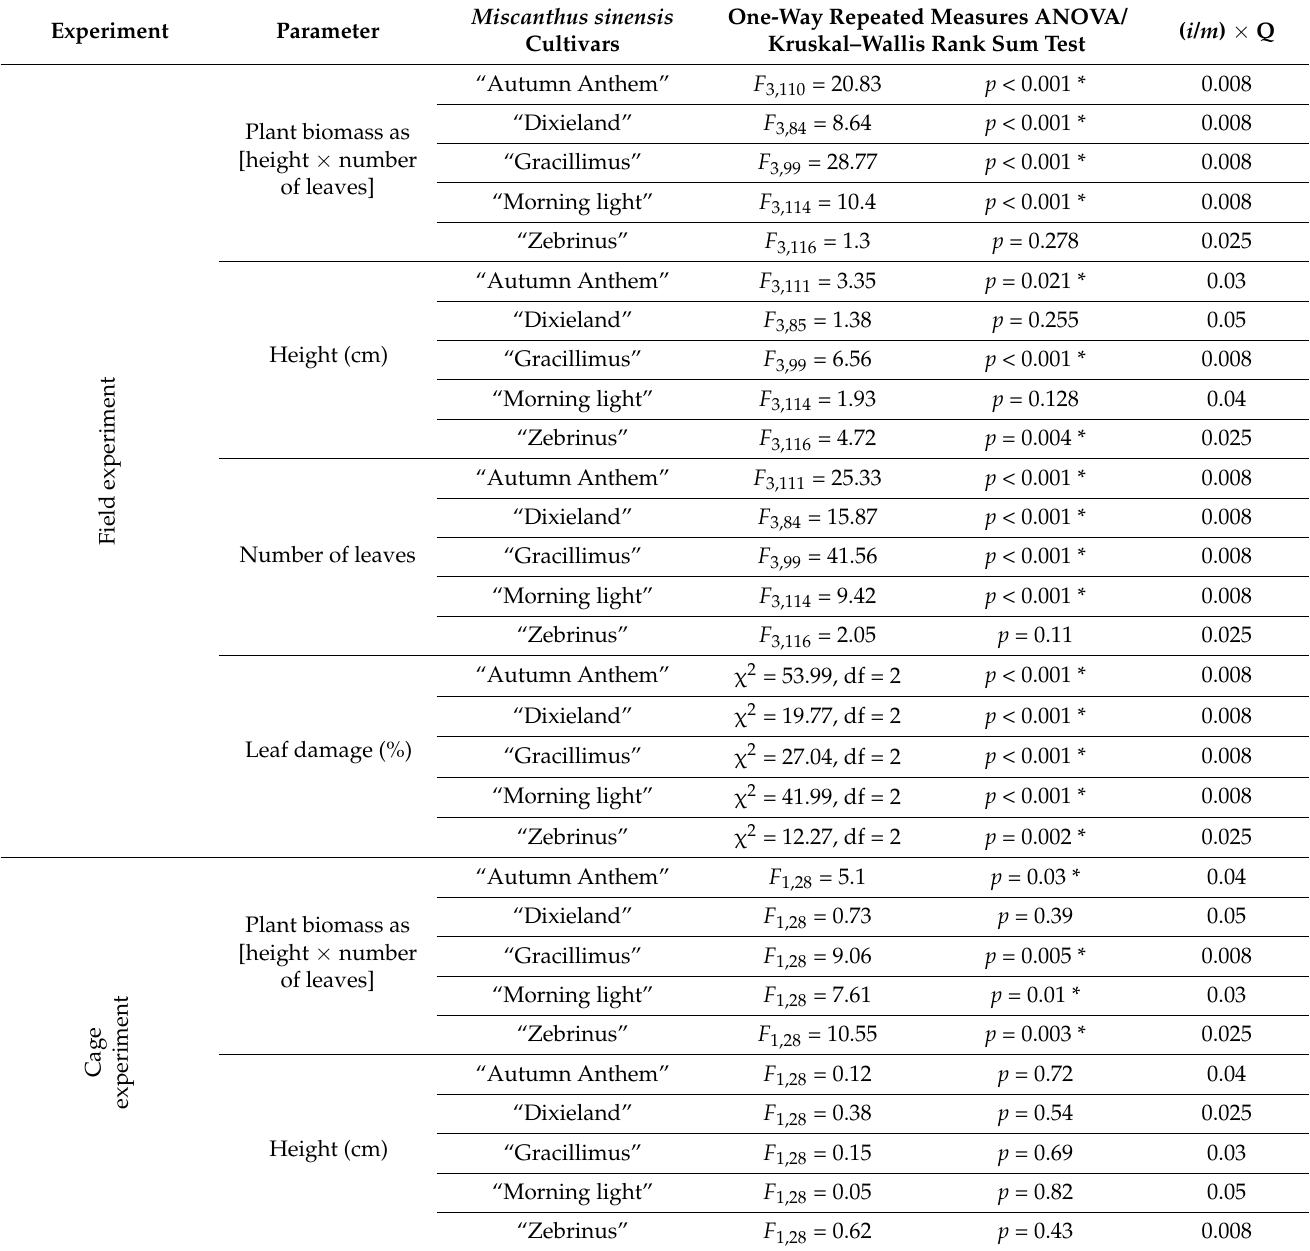
Table 1. Changes in plant responses to herbivory in five Miscanthus sinensis cultivars during the season June–August 2018 in the field and cage